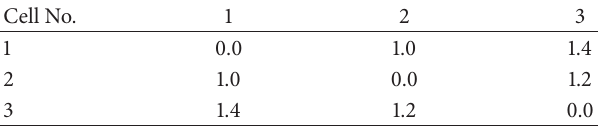
Table 5: Intercell material handling cost for Example 1. Cell